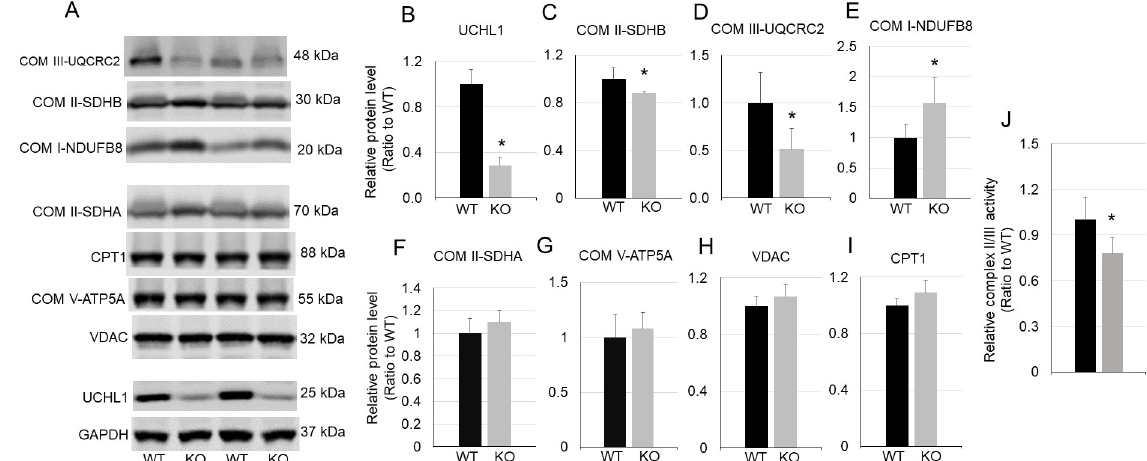
Fig 5. UCHL1 smKO alters mitochondrial OXPHOS proteins. A-I: Western blot images (A) and quantifications of Western blot of soleus samples from WT or UCHL1 smKO for UCHL1 (B), SDHB (C), UQCR2 (D), NDUFB8 (E), SDHA (F), ATP5A (G), VDAC (H), and CPT1 (I). J : Activity of complex II/III in isolated mitochondria from soleus of WT or UCHL1 smKO. � P < 0.05 vs WT, n = 4. The representative Western blot images were copied from the original membranes and each lane was positioned as the originally loaded without regrouping. The original blot images can be found in the S1